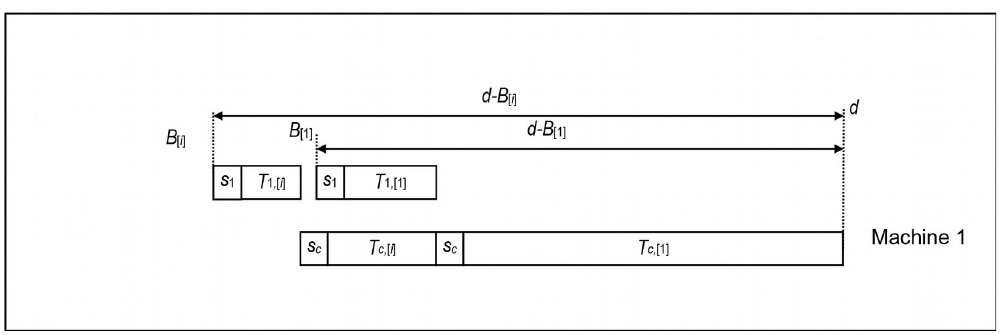
Fig. A.1. A flow shop batch